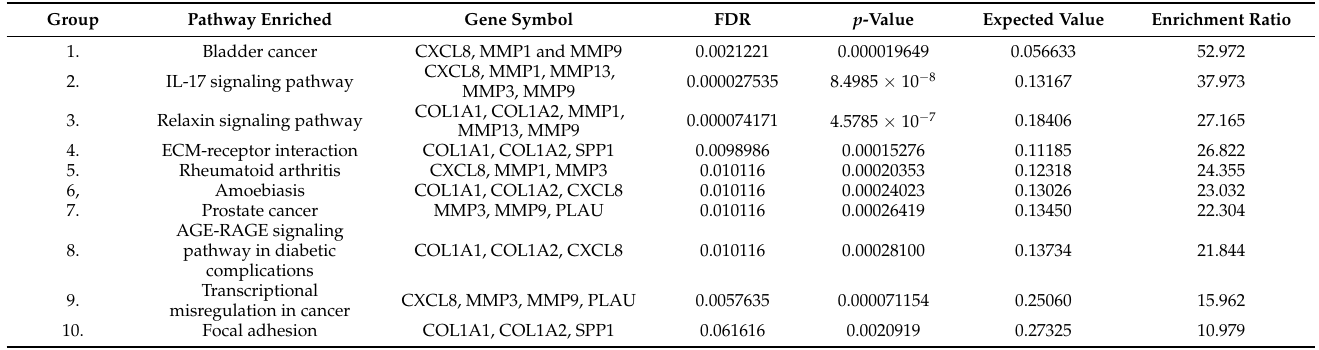
Table 2. The pathway enrichment analysis resulted in the following parameter for the predicted HGsT10